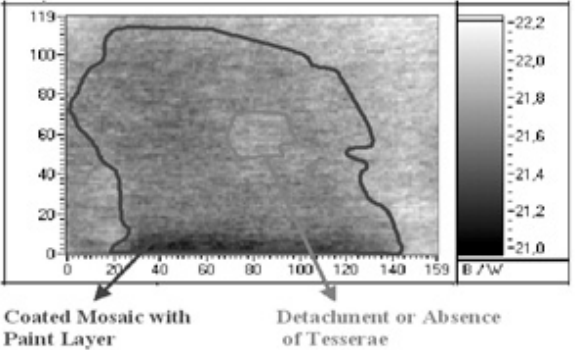
Figure 23. Thermal image of the investigated plastered mosaic surface.